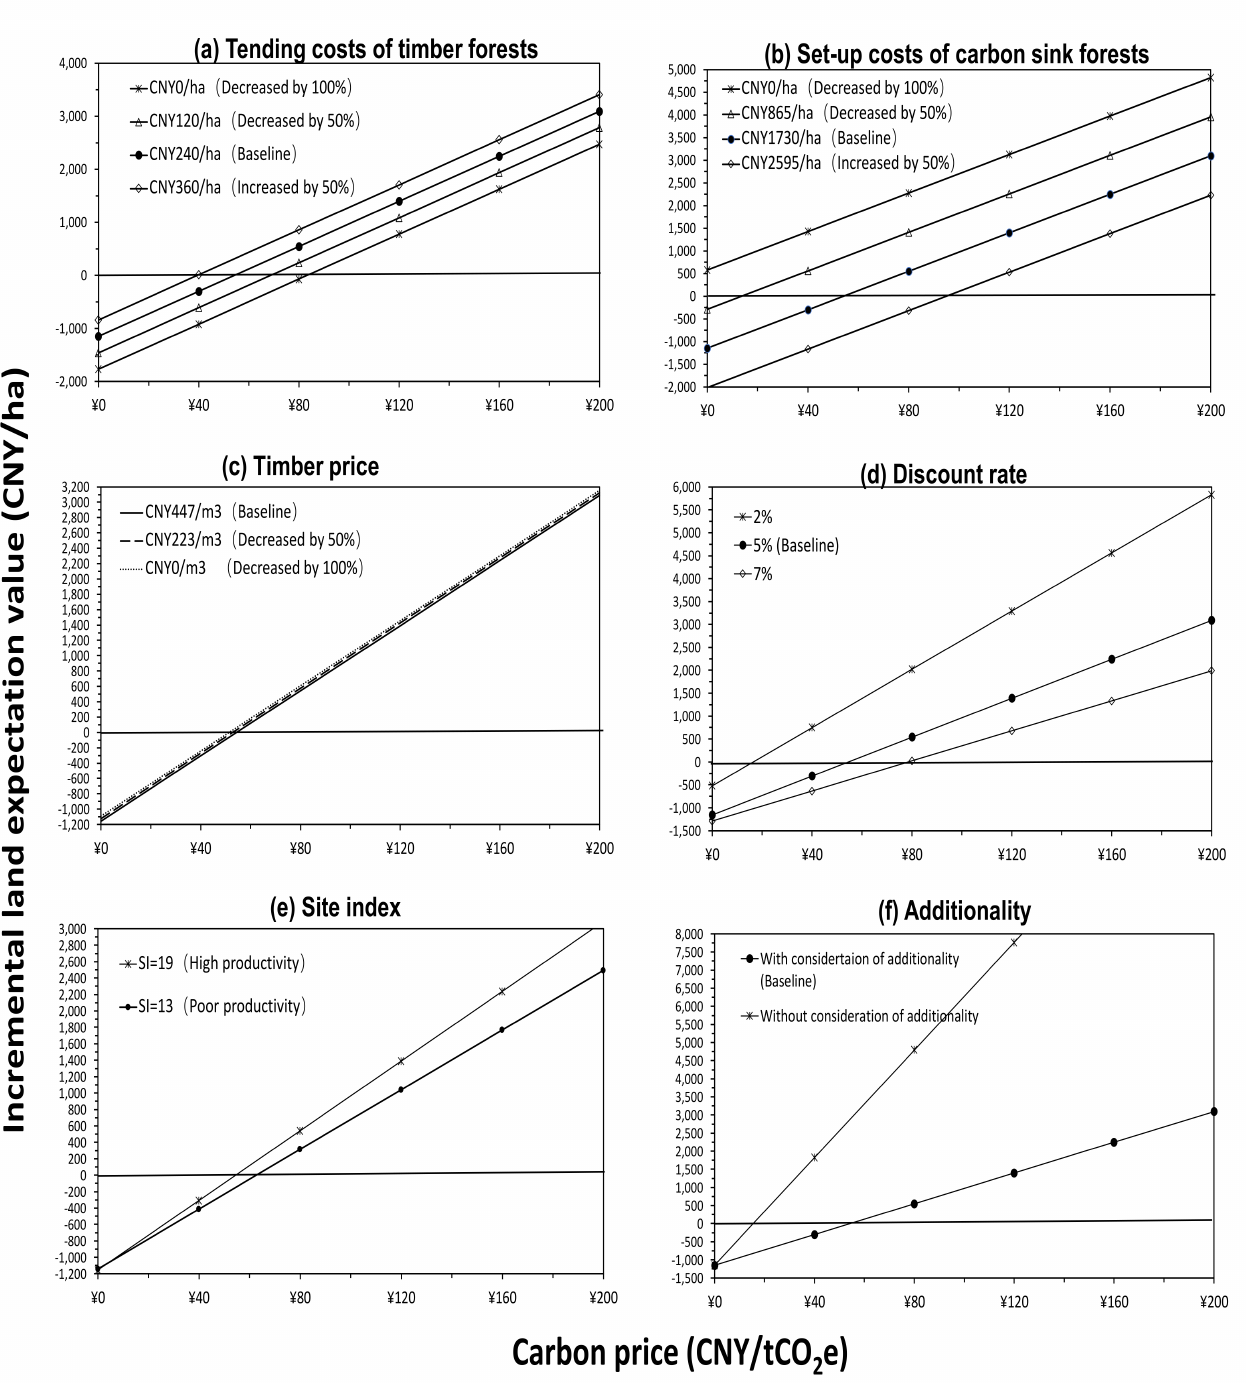
Figure 5. Impacts of changes in important parameters in the decision model on the incremental land expectation values of carbon sink forests compared with timber production forests. In each of the panels of Figure 5, a horizontal line that intersects the y -axis at the incremental land expectation value of zero is used to identify the minimum required carbon price (break-even point) that would justify enrollment in a forest carbon sink project relative to the traditional land-use goal of timber production for a particular scenario. Note: Scenarios are evaluated based on a 25-year contract term (all subfigures), a site index of 19 m ( a , b , c , d , f ), and a 5% real discount rate ( a , b , c , e , f ),